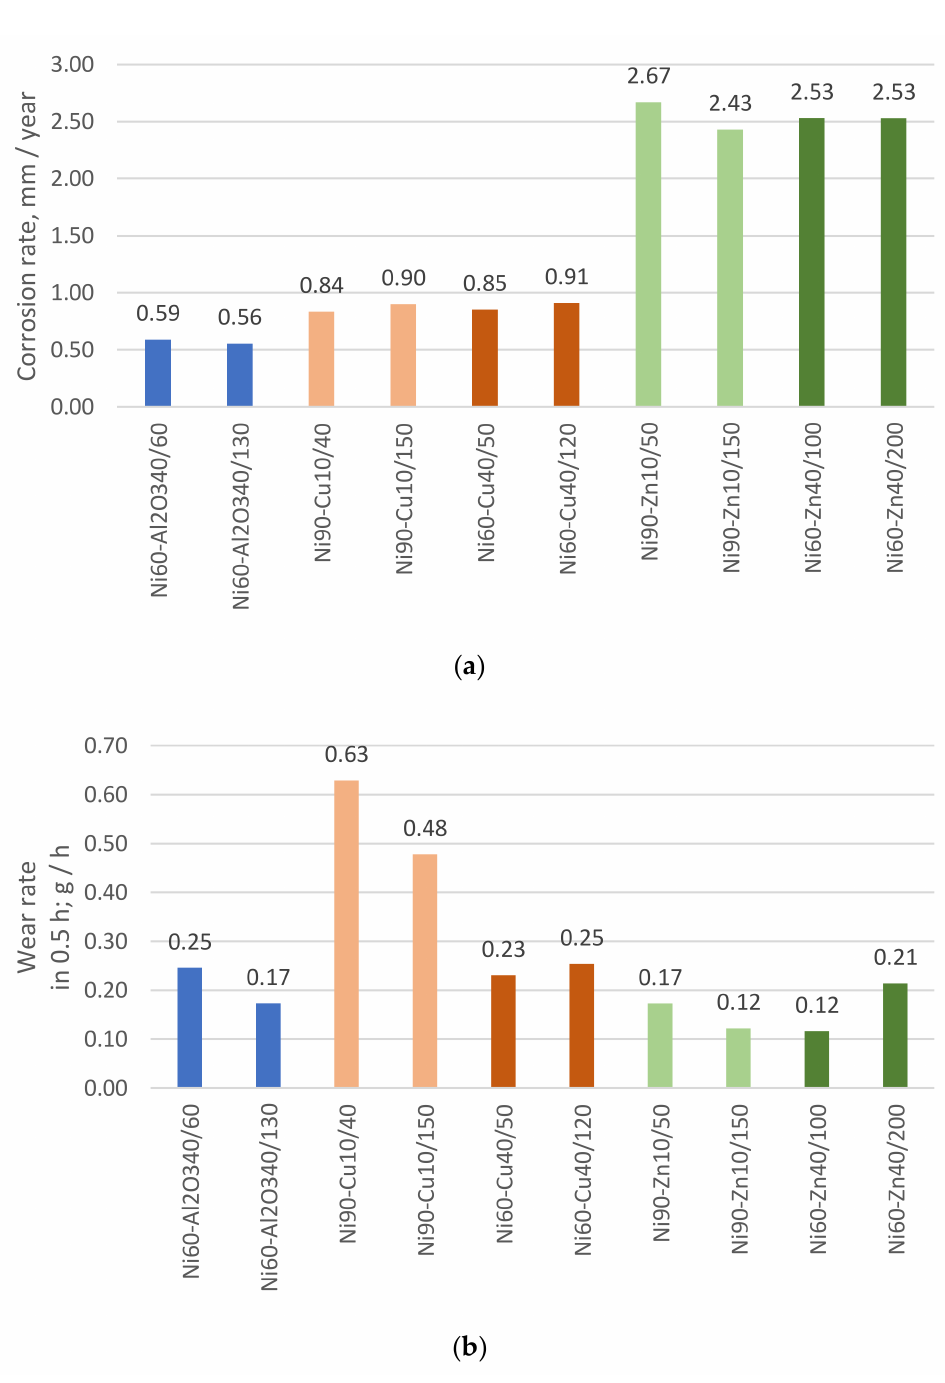
Figure 8. The influence of the coating thickness on ( a ) corrosion rate using electrochemical tests, and ( b ) resistance to hydroabrasive